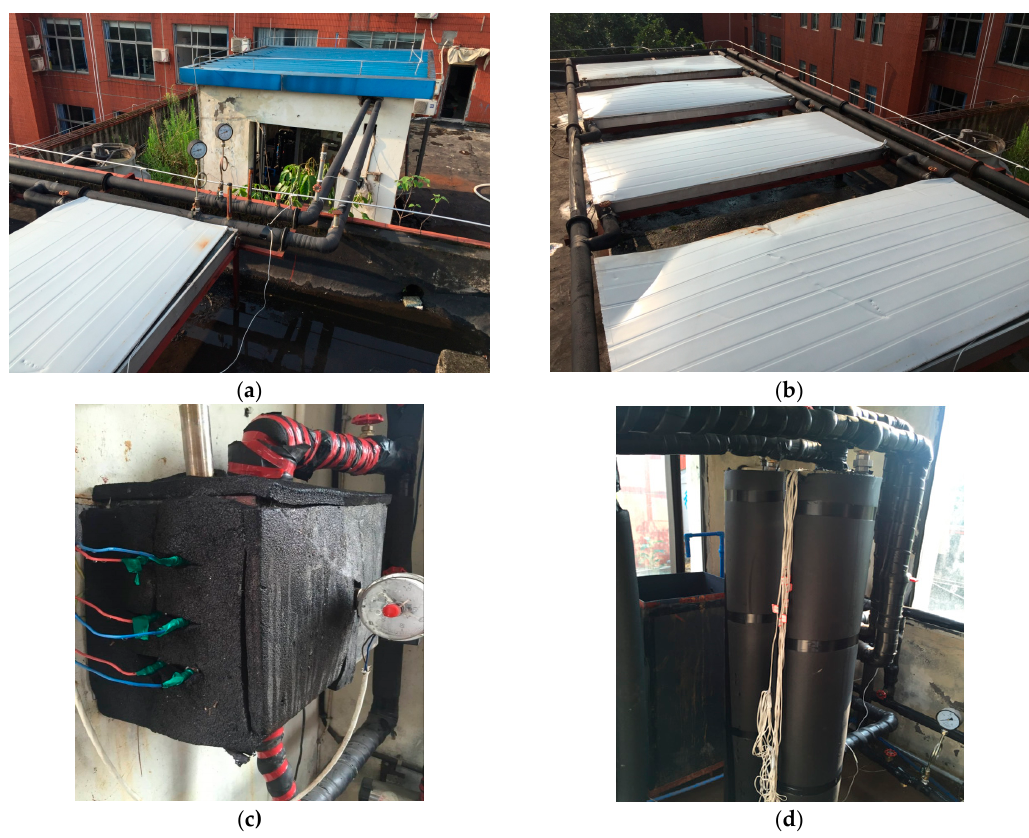
Figure 4. Photos of the experimental platform: ( a ) Over view; ( b ) Solar collectors; ( c ) Electric heater; ( d ) TES unit.